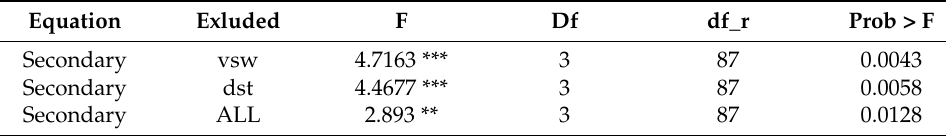
Table 4. Space weather and electricity consumption of the secondary sector.